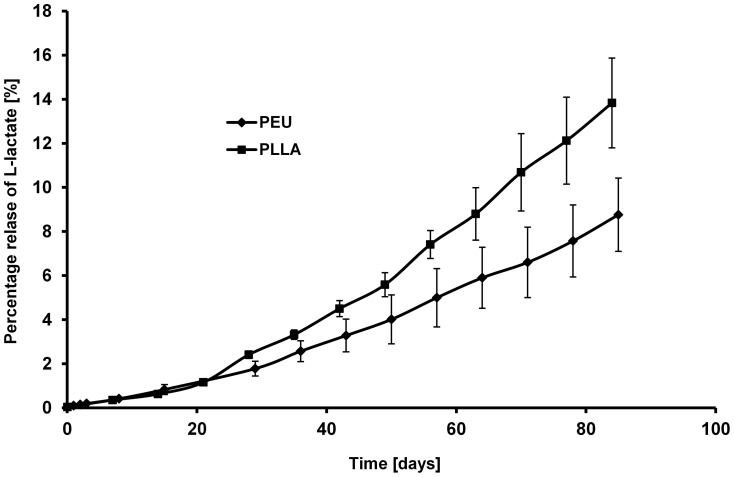
Percentage release of L-lactate from PEU and PLLA (referred to the total amount of L-lacide in non-degraded polymers) during degradation in SBF medium at 37°C.